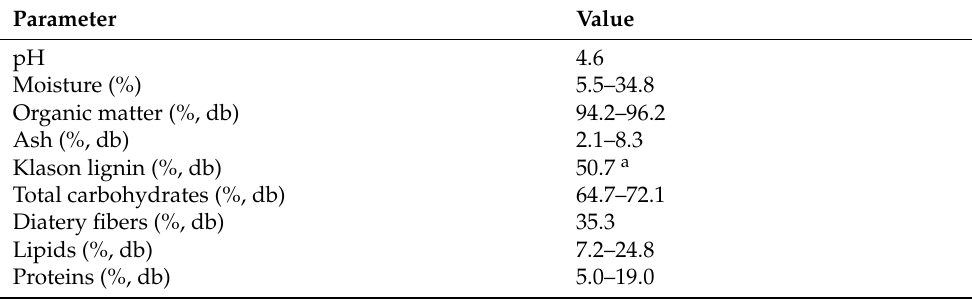
Table 2. General composition of grape seeds.